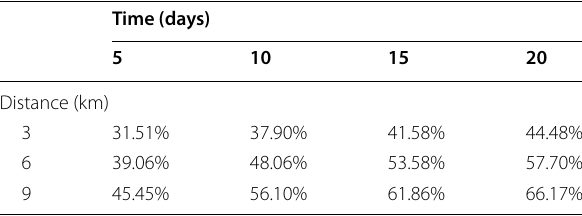
Table 3 Percentage of earthquakes that have foreshocks using various time–space